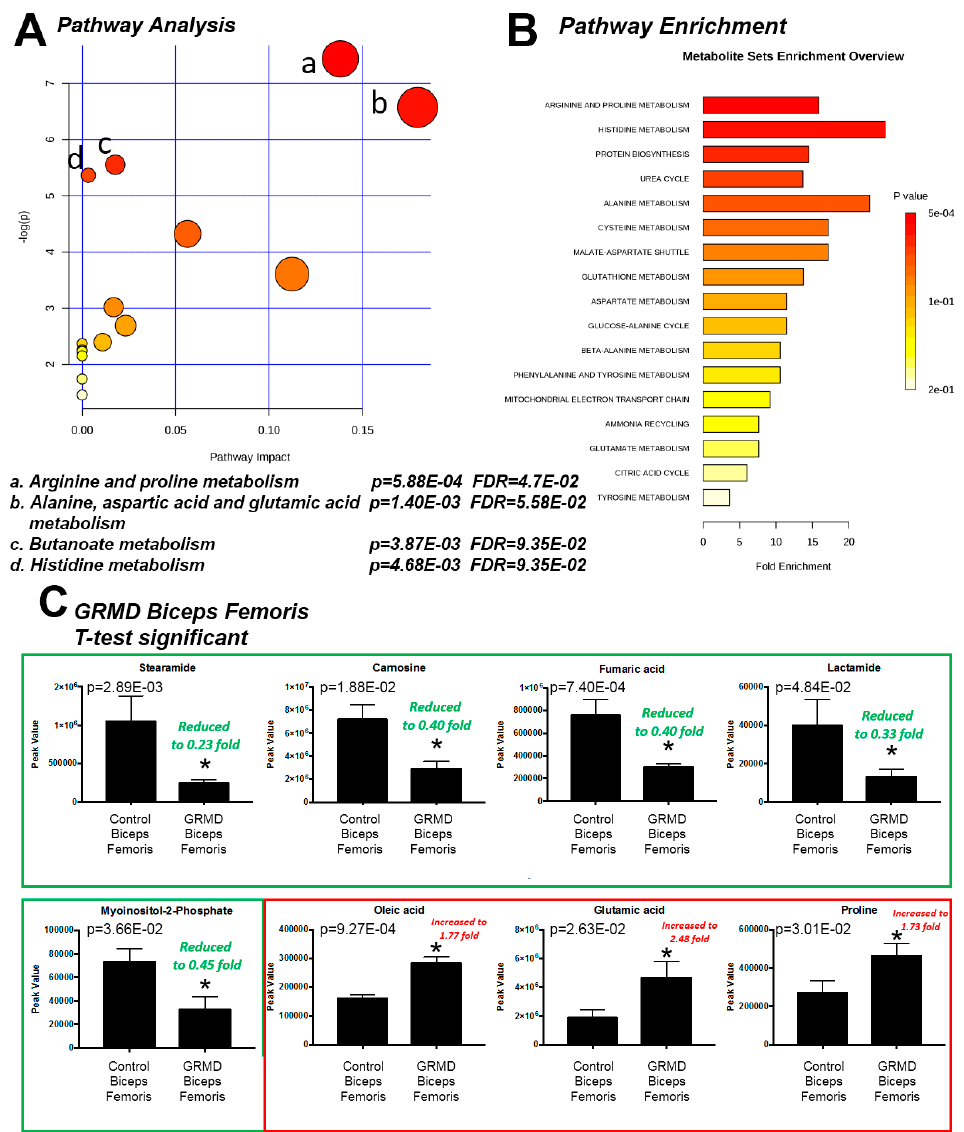
Figure 2. Pathway enrichment analysis of t -test significant metabolites from GRMD biceps femoris muscle. ( A ) Pathway analysis of t -test significant metabolites; ( B ) Enrichment analysis of t -test significant metabolites using pathway dataset for comparison; ( C ) Comparison of Peak values of t - test significant metabolites. Analysis by Metaboanalyst analysis of GRMD (N = 6) vs. control (N = 4) metabolites. Data is presented as the mean +/- SEM.